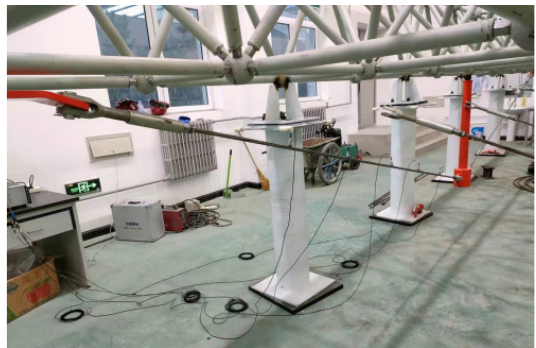
Figure 14. Cable frequency test photograph of the cable-stayed structure.